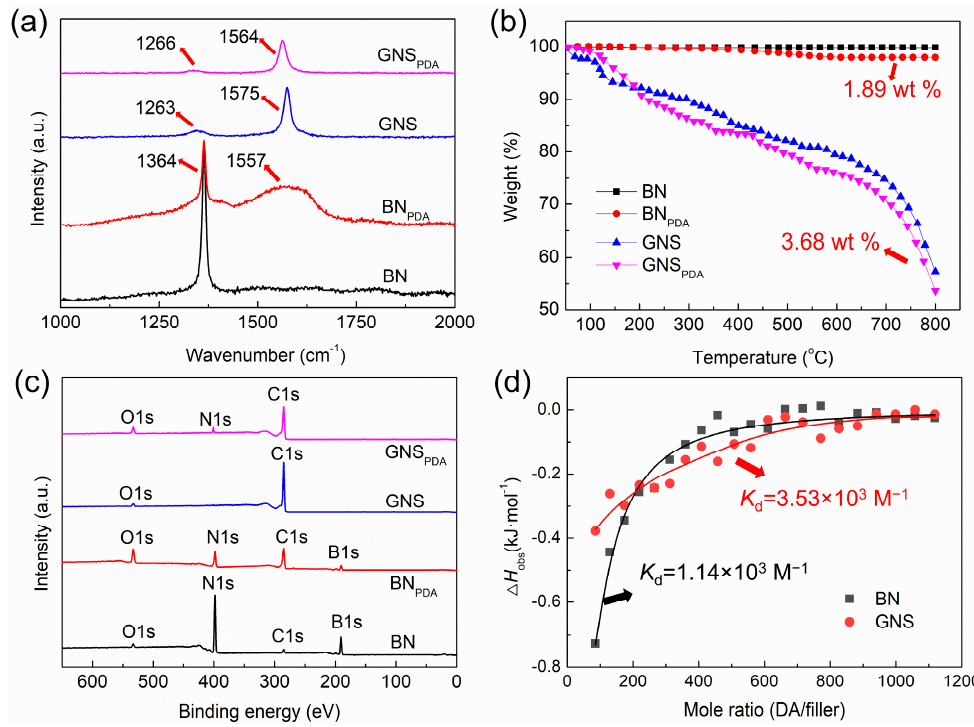
Figure 1. ( a ) Raman spectra, ( b ) TGA analysis, and ( c ) XPS spectra of BN, BN PDA , GNS, and GNS PDA . ( d ) ITC analysis of the enthalpy changes ( Δ H obs ) relative to the PDA/BN (or GNS) molar ratio. The cross-section of four fi lms, pure BC (Figure S3), BC/BN PDA (the mass ratio of BN fi llers is 70 wt%), BC/BN PDA /GNS PDA -5 (the total mass ratio of hybrid fi llers is 70 wt% and the mass ratio of GNS PDA is 5 wt%), and BC/BN PDA /GNS PDA -10 (the total mass ratio of hy- brid fi llers is 70 wt% and the mass ratio of GNS PDA is 10 wt%) were observed from SEM.